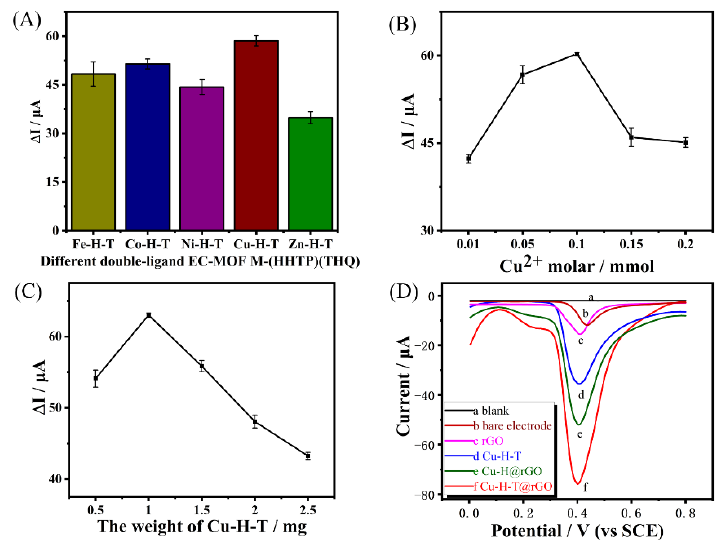
Figure 1. Current responses ( A ) of various M-H-T/GCEs, ( B ) of Cu-H-T@rGO/GCE containing Cu-H-Ts prepared using different Cu 2+ contents (but constant HHTP and THQ contents, both equal to 0.02 mmol), and ( C ) of Cu-H-T@rGO/GCE containing different Cu-H-T/rGo ratios (expressed as Cu-H-T weight in the mixture) to a 0.1 mmol·L − 1 BPA solution. Each data point in ( A – C ) represents an average of five measurements, while the error was calculated as a standard deviation. ( D ) DPV of blank, bare GCE, rGO/GCE, Cu-H-T/GCE, Cu-H@rGO/GCE and Cu-H-T@rGO/GCE under the presence of 0.1 mmol·L − 1 BPA at pH = 7.0.